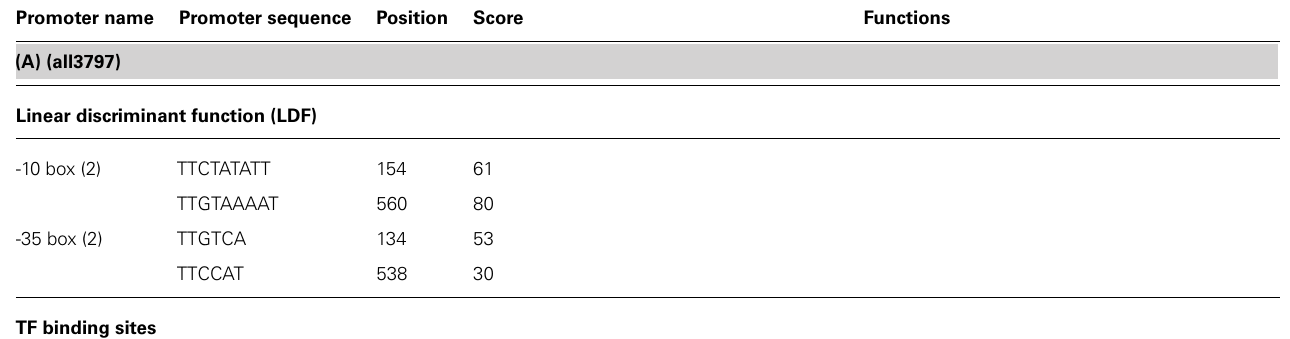
Table 2 | Prediction of UTR and promoter regions of hypothetical proteins all3797 and